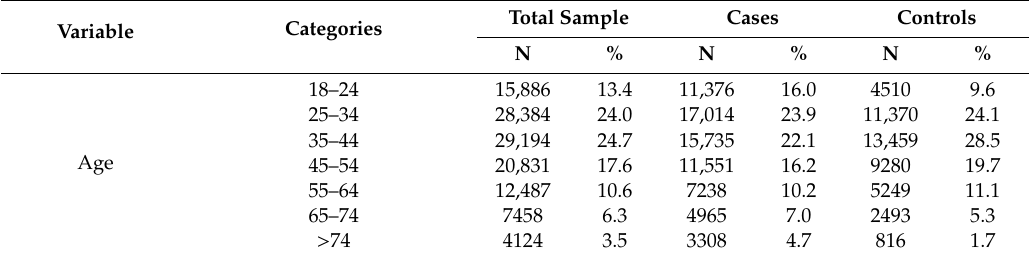
Table 1. Distribution of the study variables in the total sample of drivers and stratified by case and control